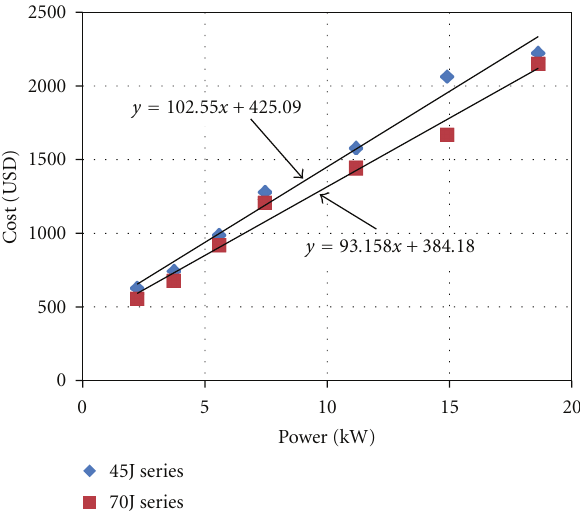
Figure 6: Cost of pumps as function of the pump size (power) for two series of